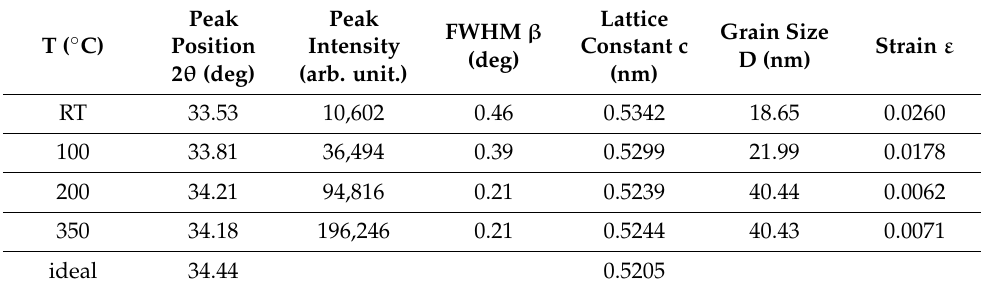
Table 1. Structural information of ZnO thin films compared with